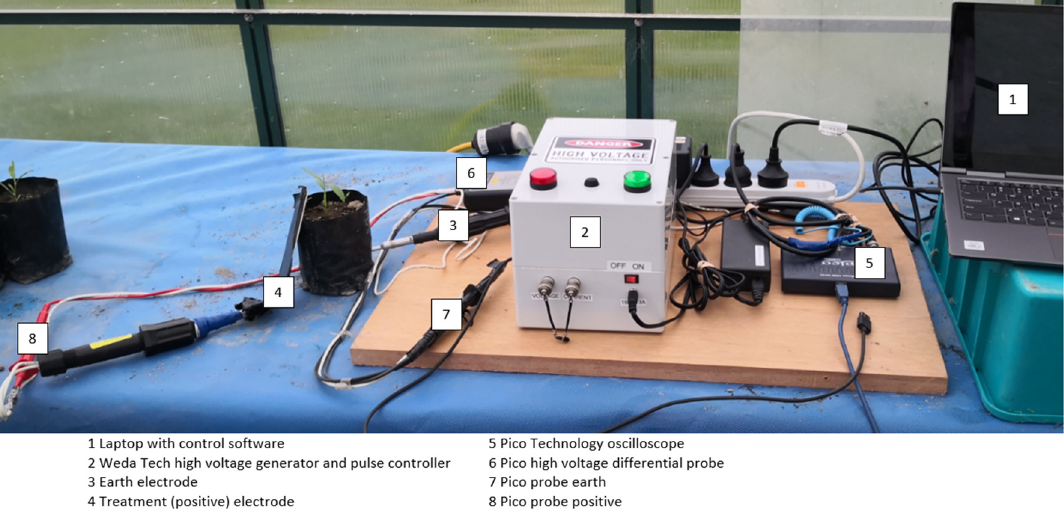
Figure 1. Photograph showing multi-pulse DC treatment equipment including picoscope to monitor voltage and current discharge.